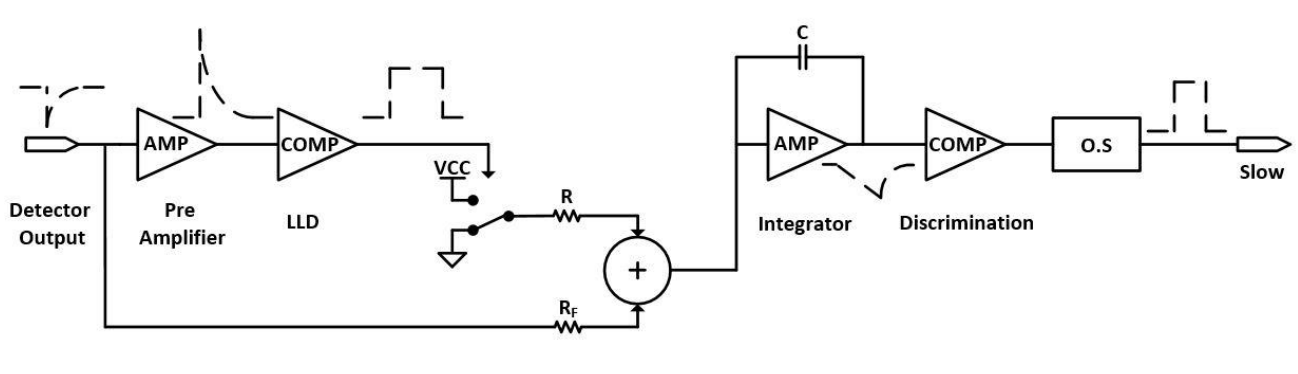
Fig. 8. Scheme of the proposed time duration and pulse height discrimination